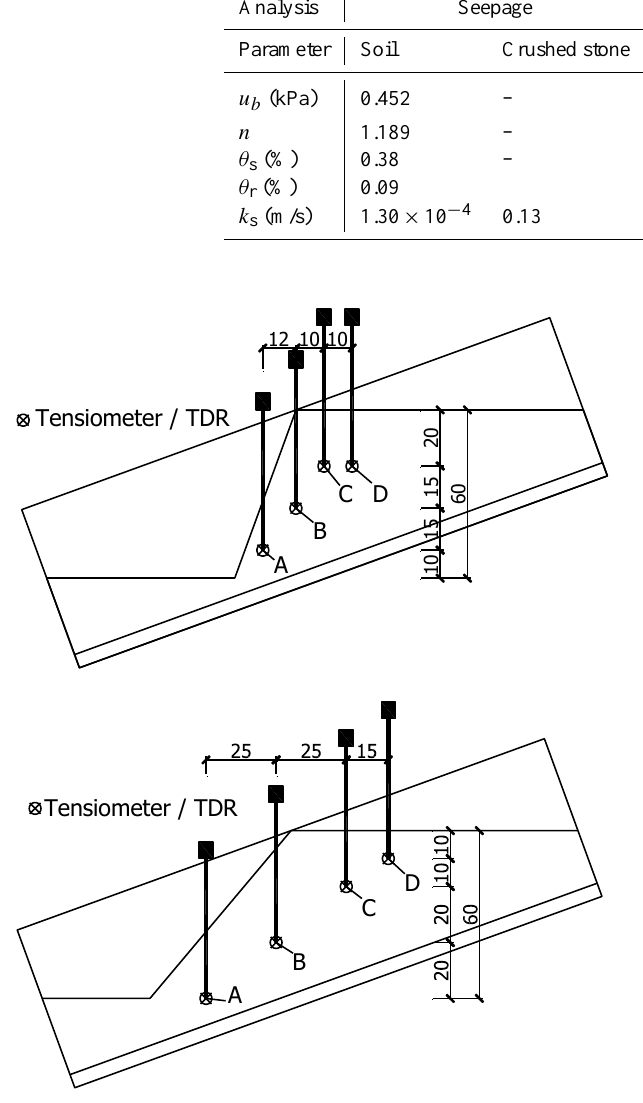
Figure 2. Model slope with arrangement of the TDR and tensiome- ter: (a) model slope of 70 ◦ inclination, (b) model slope of 50 ◦ in-